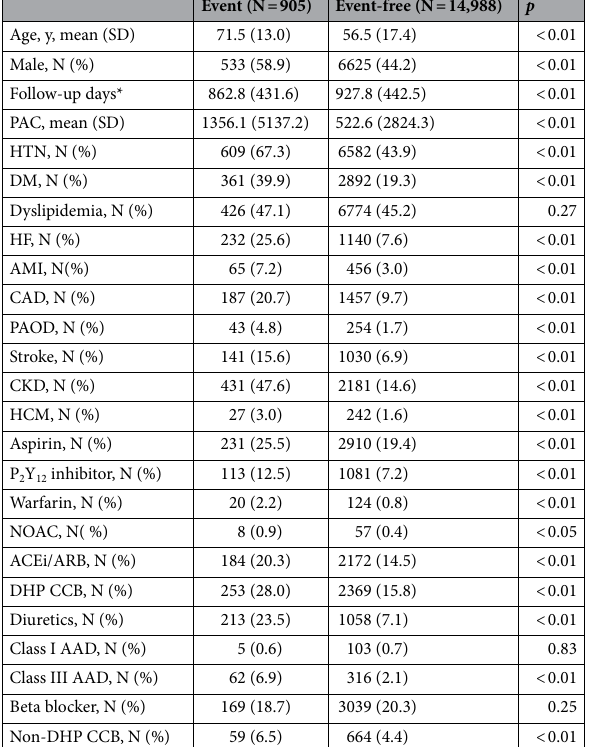
Table 1. Demographic and clinical characteristics of overall study cohort, and event and event-free groups. Abbreviations: AAD antiarrhythmic drug, ACEi/ARB angiotensin-converting enzyme inhibitor/angiotensin receptor blocker, AMI acute myocardial infarction, CAD coronary artery disease, CKD chronic kidney disease, DHP CCB dihydropyridine calcium channel blocker, DM diabetes mellitus, HCM hypertrophic cardiomyopathy, HF heart failure, HTN hypertension, Non-DHP CCB non-dihydropyridine calcium channel blocker, PAOD peripheral arterial occlusive disease, PAC premature atrial complex, PVC premature ventricular complex, NOAC novel oral anticoagulant. *Represents median follow-up